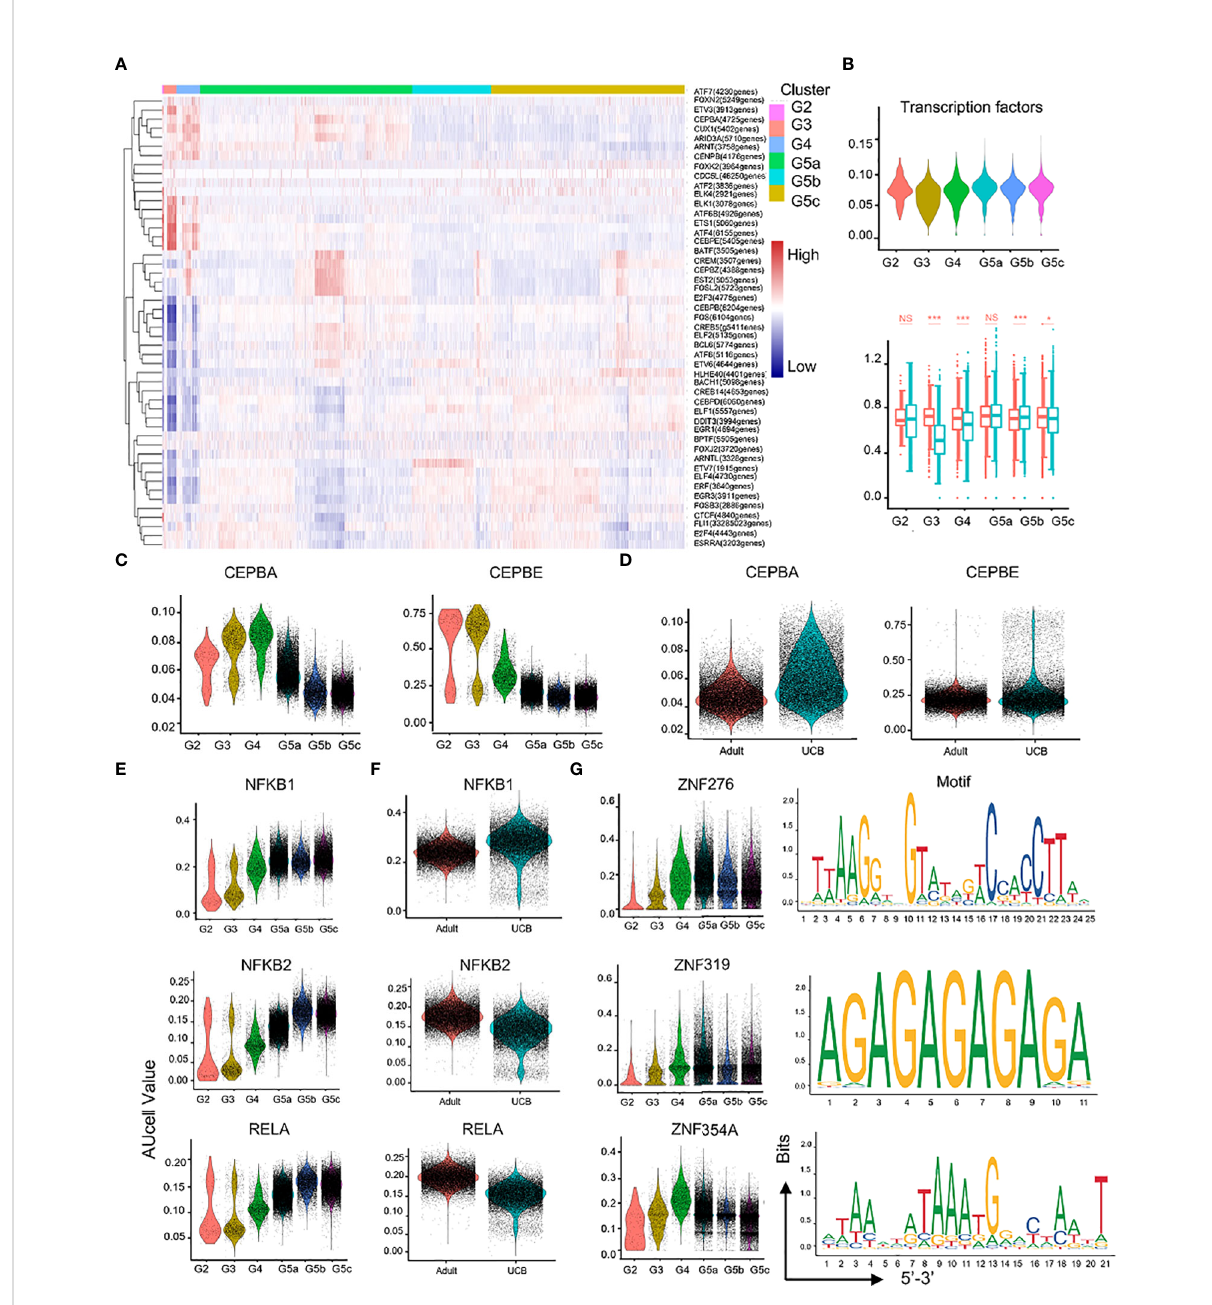
FIGURE 7 Characteristics of transcription and communication in neutrophil subsets. (A) Heatmap for transcription factors with different regulatory intensities in each subset of neutrophils. (B) Violin plot of characteristic transcription factors of neutrophils in each subset. Box plot of neutrophilic transcription factor scores between UCB and adults in each subset. (C – F) Violin plot of different activity of transcription factors in neutrophil subsets. (G) Activity and motif description based binding sites of three novel transcription factors in neutrophil subsets. *p < 0.05, ***p < 0.001, NS, not